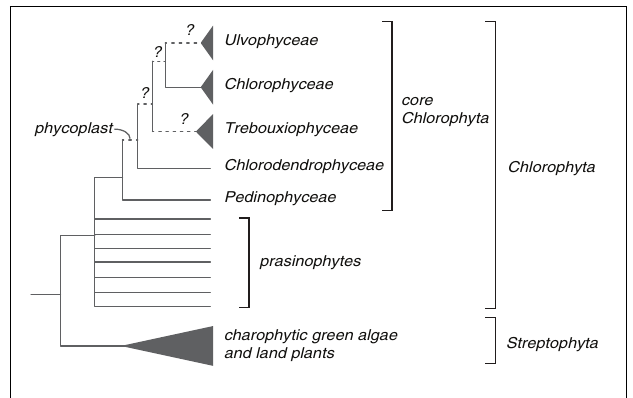
FIGURE 1 | Schematic overview of the current classification of Chlorophyta into classes and their phylogenetic relationships. Question marks (?) indicate uncertain